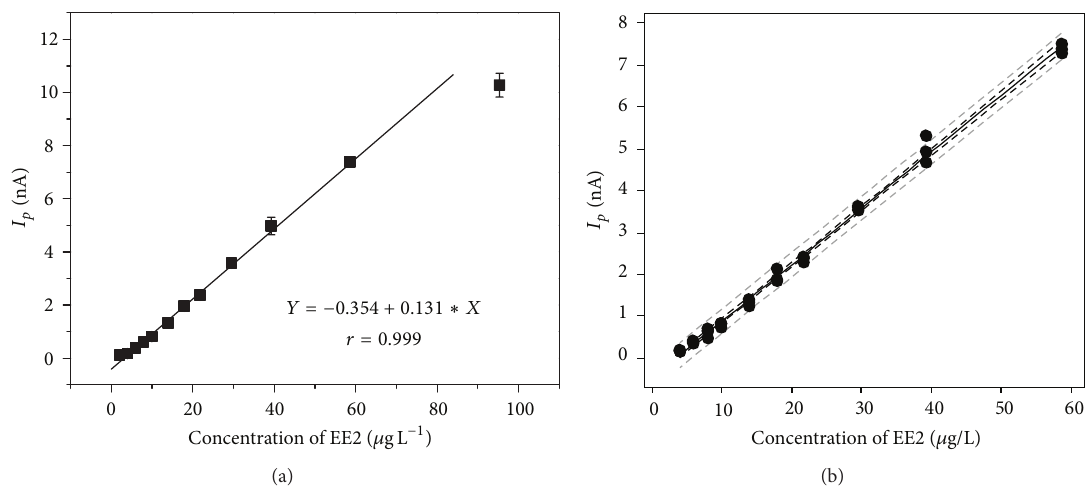
Figure 4: Calibration and linearity studies for quantification of EE2 by DP AdCSV. (a) Standard addition curve for EE2 with B-R buffer (pH 7). (b) Analytical curve (—) with confidence intervals (CI) (— —) and prediction intervals (PI) (-----) at 95% confidence